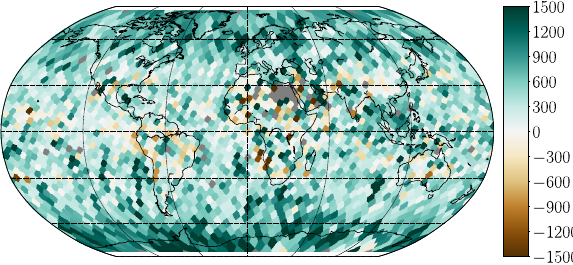
Figure 8. Mean absolute error difference in meters between MODIS-C6 and NN-AVHRR compared to CALIOP. Results are calculated for bins evenly spread out 250km apart. Bins with fewer than 10 cloudy pixels are excluded (plotted in dark grey). Dark green means NN-AVHRR is 1.5km better than MODIS-C6, dark brown means MODIS-C6 is 1.5km better than NN-AVHRR. The final validation and testing under development data (see Table 1) are included to get enough